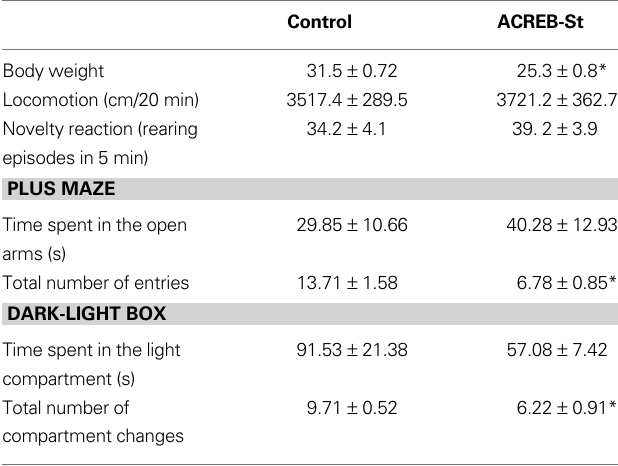
Table 1 | General characterization of ACREB-St